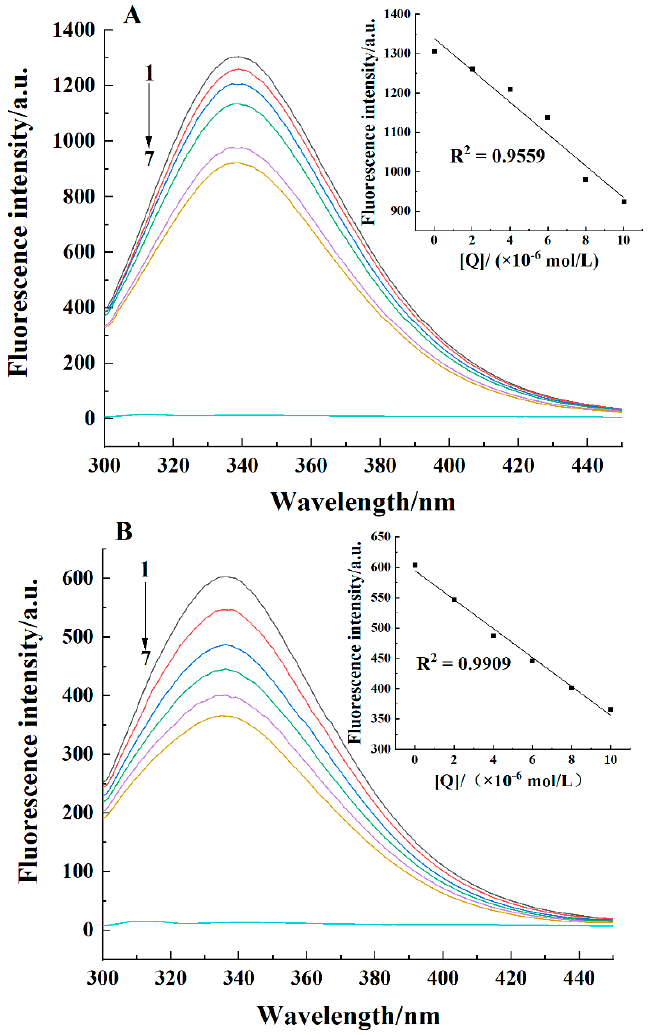
Figure 1. Fluorescence spectra of casein in the absence and presence of curcumin at 298 K at pH 7.4 ( A ) and pH 2.0 ( B ). The curcumin concentrations in curves 1–6 were 0 × 10 − 6 , 2 × 10 − 6 , 4 × 10 − 6 , 6 × 10 − 6 , 8 × 10 − 6 , and 10 × 10 − 6 mol/L. Curve 7 was for 0.05 mol/L Tris-HCl buffer. Casein concentration was 0.2 g/L.